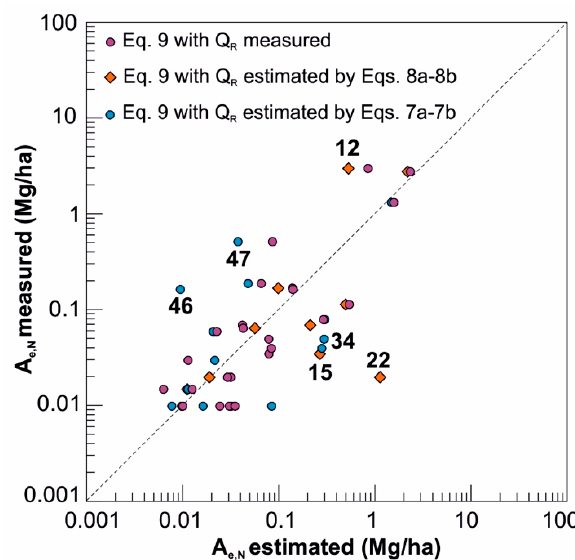
Figure 6. Goodness of fit of the soil loss measured and estimated by the USLE-MM model (Equation (9)) with Q R measured and estimated by Equations (7a,b) and (8a,b). Blue dots and orange diamonds indicate autumn–winter and spring–summer events, respectively. The numbers associated with some selected events are referred to in Table S1.